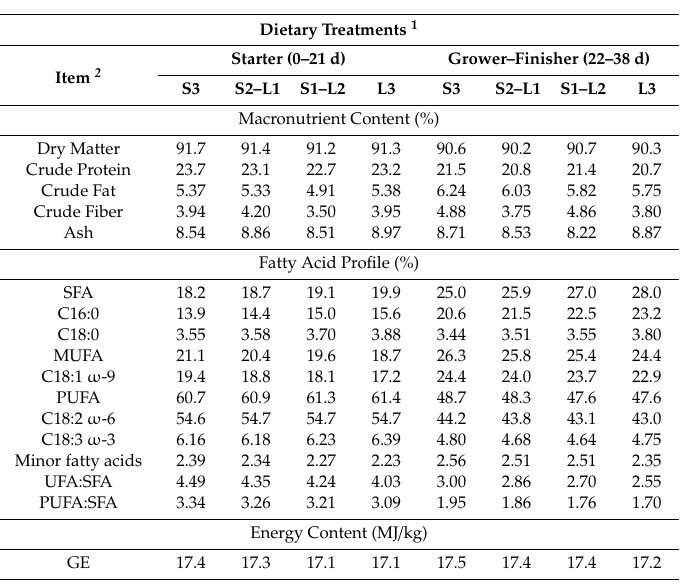
Table 3. Analyzed gross energy, macronutrient content and fatty acid composition of starter and grower–finisher broiler chicken diets (Experiment